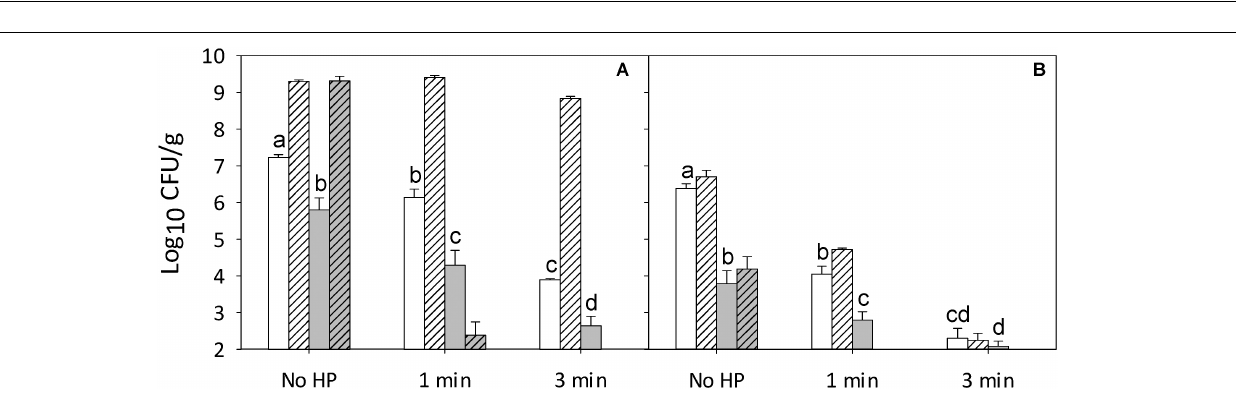
FIGURE 3 | Effect of pressure on survival and post-pressure growth of L. monocytogenes and RTE meat microbiota on ham. Ham was inoculated with a 5-strain cocktail of L. monocytogenes (A) or RTE meat microbiota (B) and treated at 500 MPa for 1 or 3 min with 0.02 N HCl (solvent control) or an equivalent volume of a nisin preparation in 0.02 N HCl to achieve a concentration of 2 µ g/ cm 2 , corresponding to 0.05 µ g/cm 2 pure nisin. Cell counts of L. monocytogenes and RTE meat microbiota were monitored immediately after pressure treatment (solid columns) and after storage for 4 weeks at 4 ◦ C (hatched columns). Surviving cells were enumerated on non-selective TS ( L. monocytogenes ) or APT agar (other strains). Data are shown as means ± standard deviations of triplicate independent experiments. Treatment means (solid columns) within each panel with different letters are significantly different ( P < 0.05). The interception point of abscissa and ordinate represents the highest detection limit.